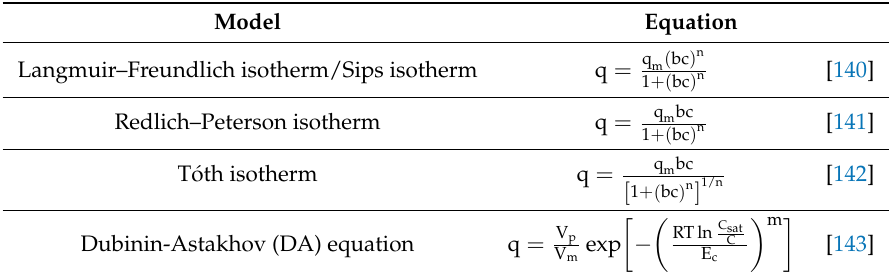
Table 4. Characteristic equations of three-parameter